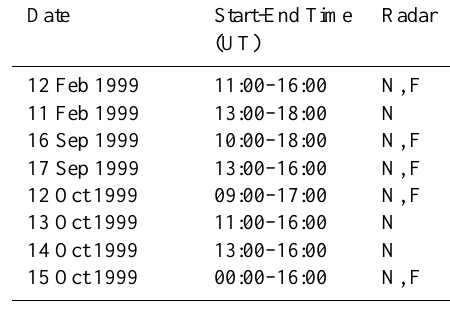
Table 1. Joint STARE/EISCAT events selected for the comparison.